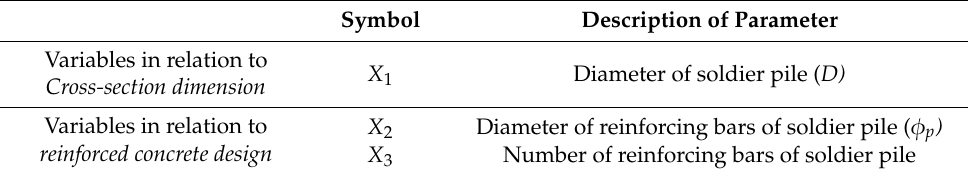
Table 1. Definitions of wall design variables.